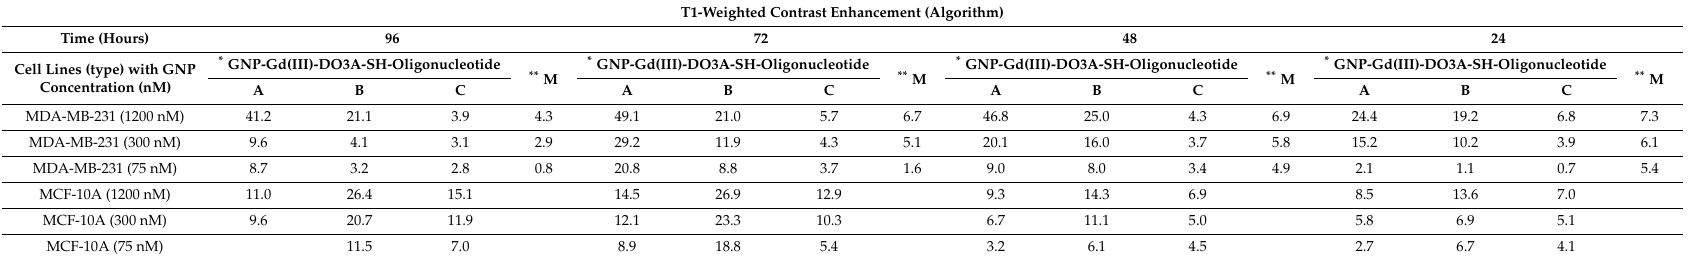
Table 4. T1-Weighted contrast enhancement comparison for GNP Gd(III)-DO3A-SH oligonucleotide in MDA-MB-231 & MCF-10A cell lines using T1-weighted image analysis